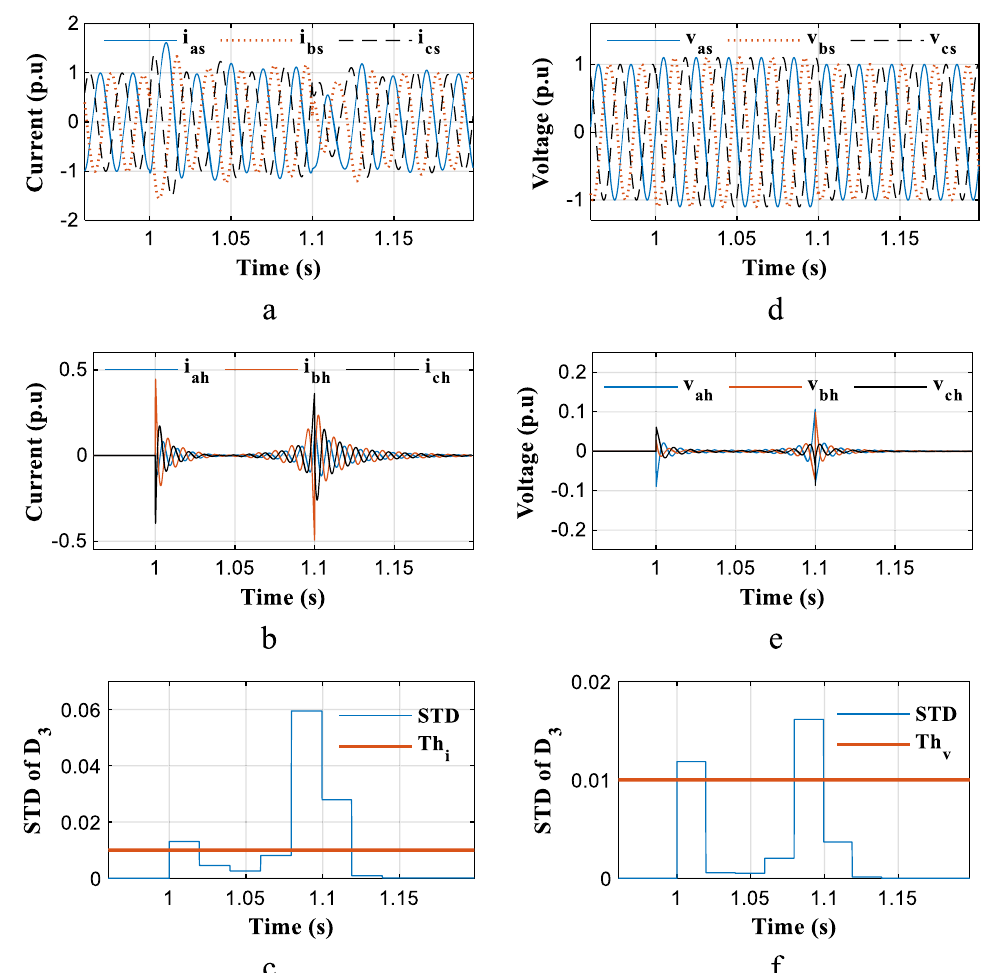
Fig. 11 Performance evaluation of proposed criteria using simulation results for a voltage swell of 10%, a Three-phase stator current signals, b High-frequency components of three-phase stator current signals, c The current criterion, d Three-phase stator voltage signals, e High-frequency components of three-phase stator voltage signals, f The voltage